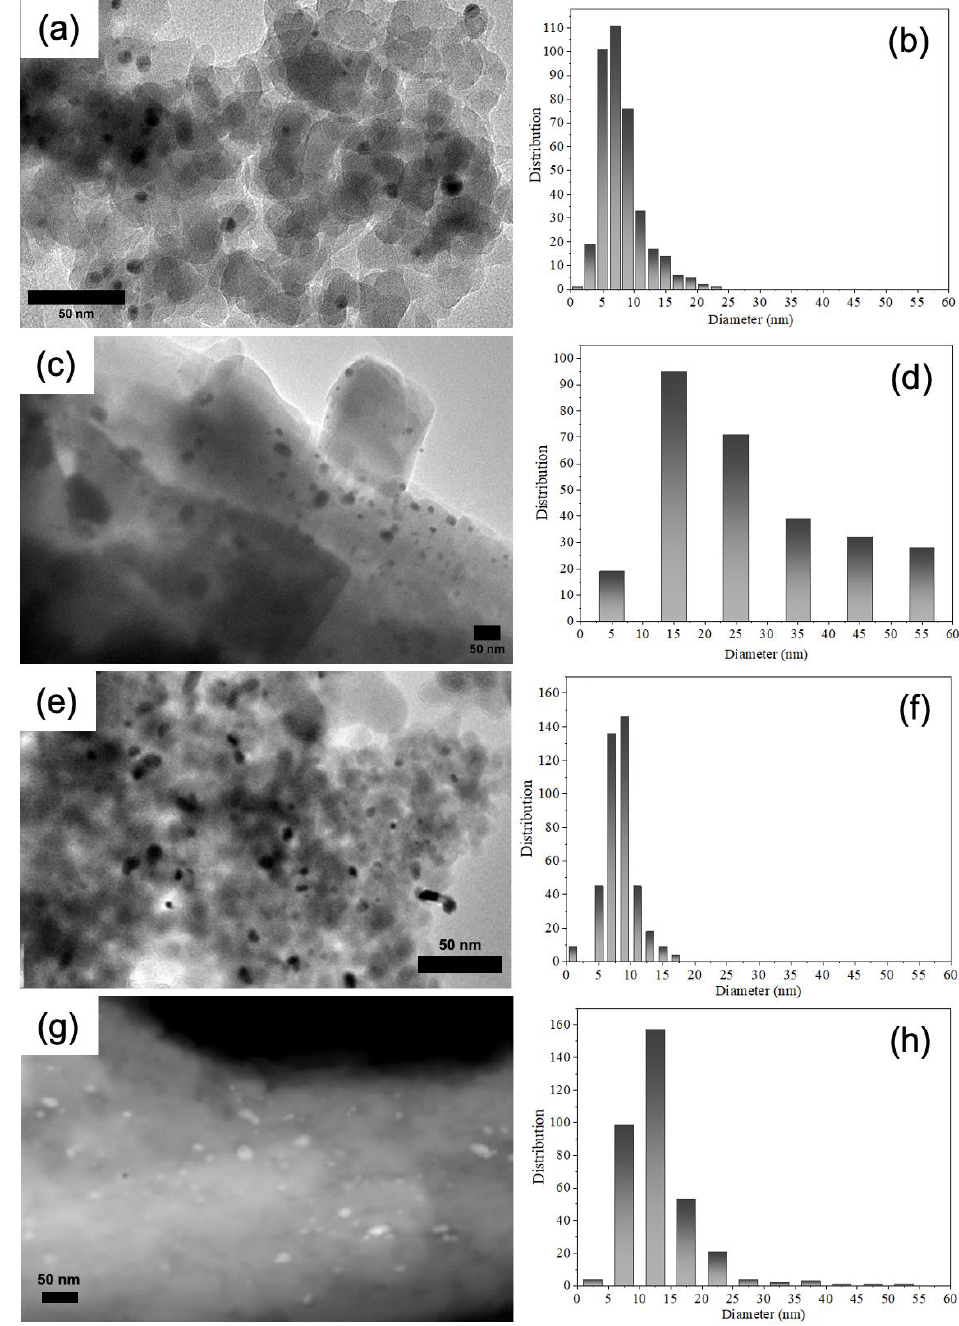
Figure 3 . TEM images and particle size distribution for ( a , b ) Pd/SiO 2 , ( c , d ) Pd/HZSM5, ( e , f ) Ru/SiO 2 , and ( g , h ) Ru/HZSM5. ( a , c , e ) represent bright-field TEM images and ( g ) dark-field TEM images. Table 2. Total amount of ammonia desorbed and acidic sites strength distribution for palladium- and ruthenium-based